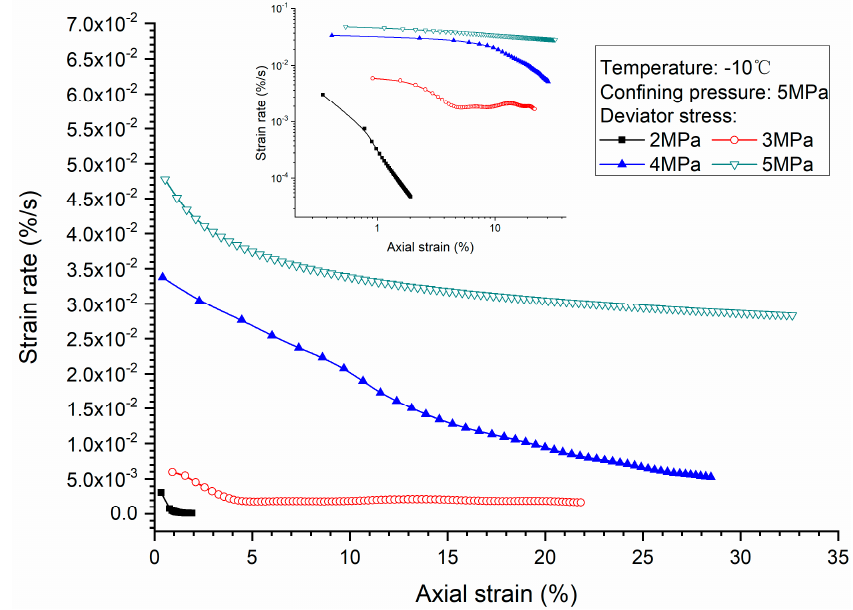
Figure 7. Creep strain rate versus axial strain for methane hydrate-bearing frozen specimens under high deviator stresses.